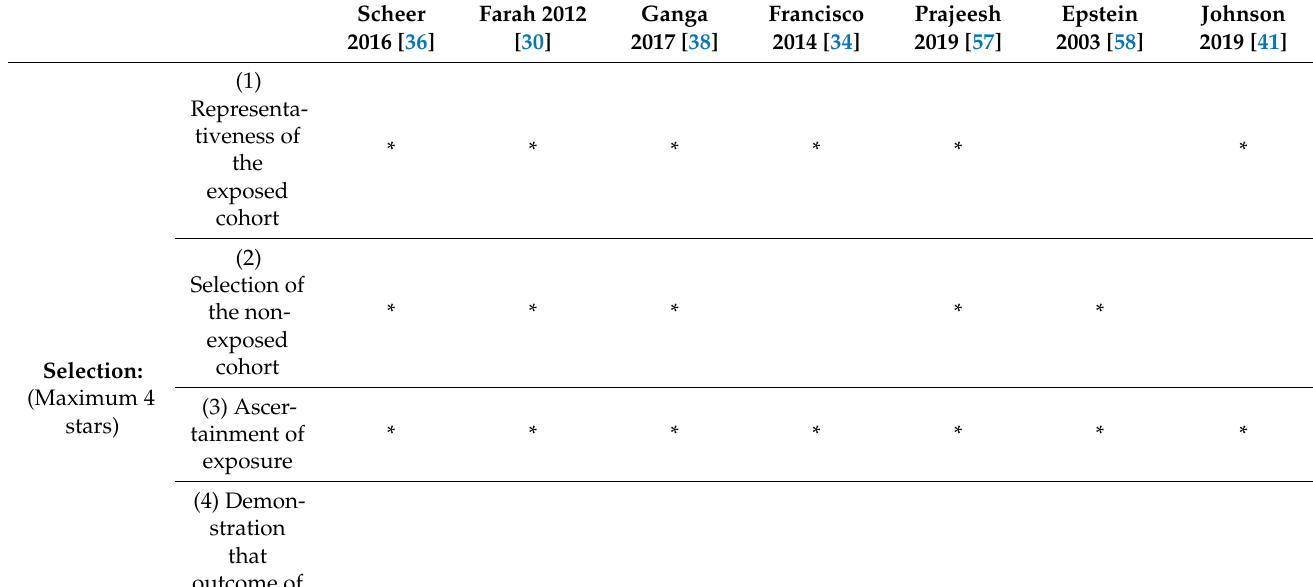
Table 5. Newcastle-Ottawa quality assessment scale cohort